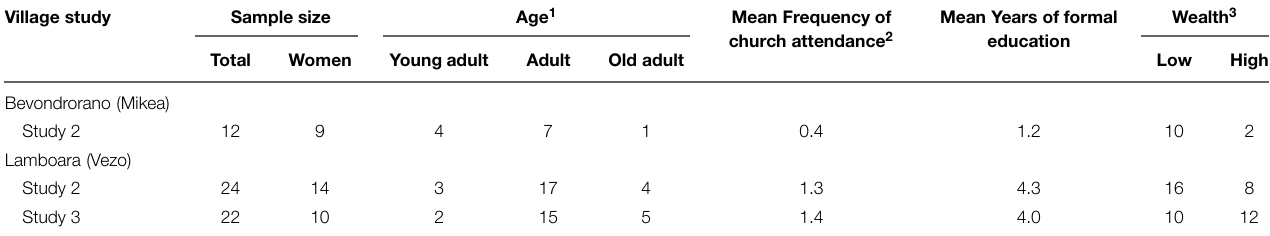
TABLE 3 | Sample characteristics for Studies 2 and 3. Village